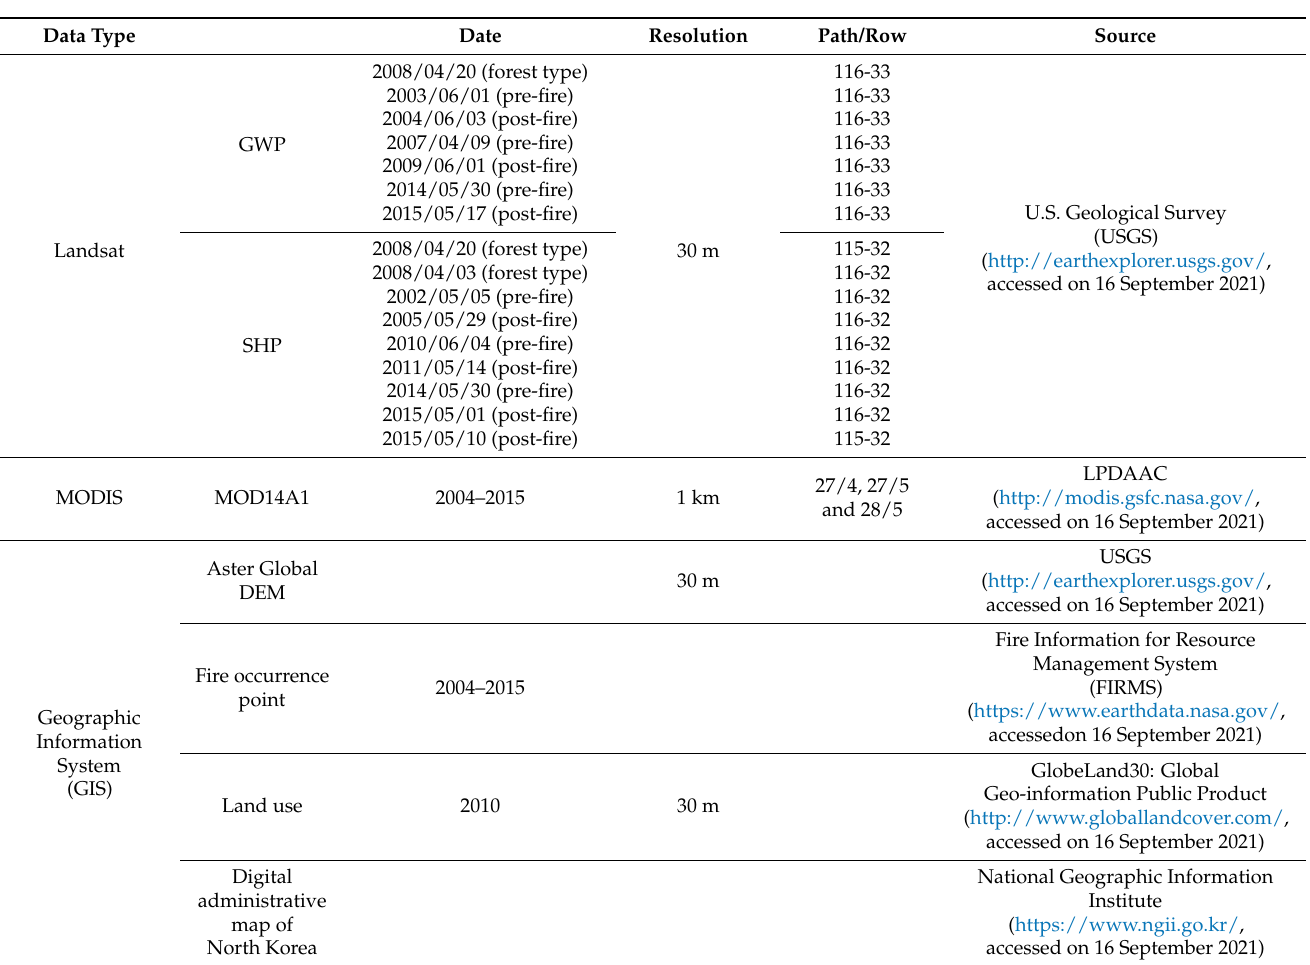
Table 1. Data used in this